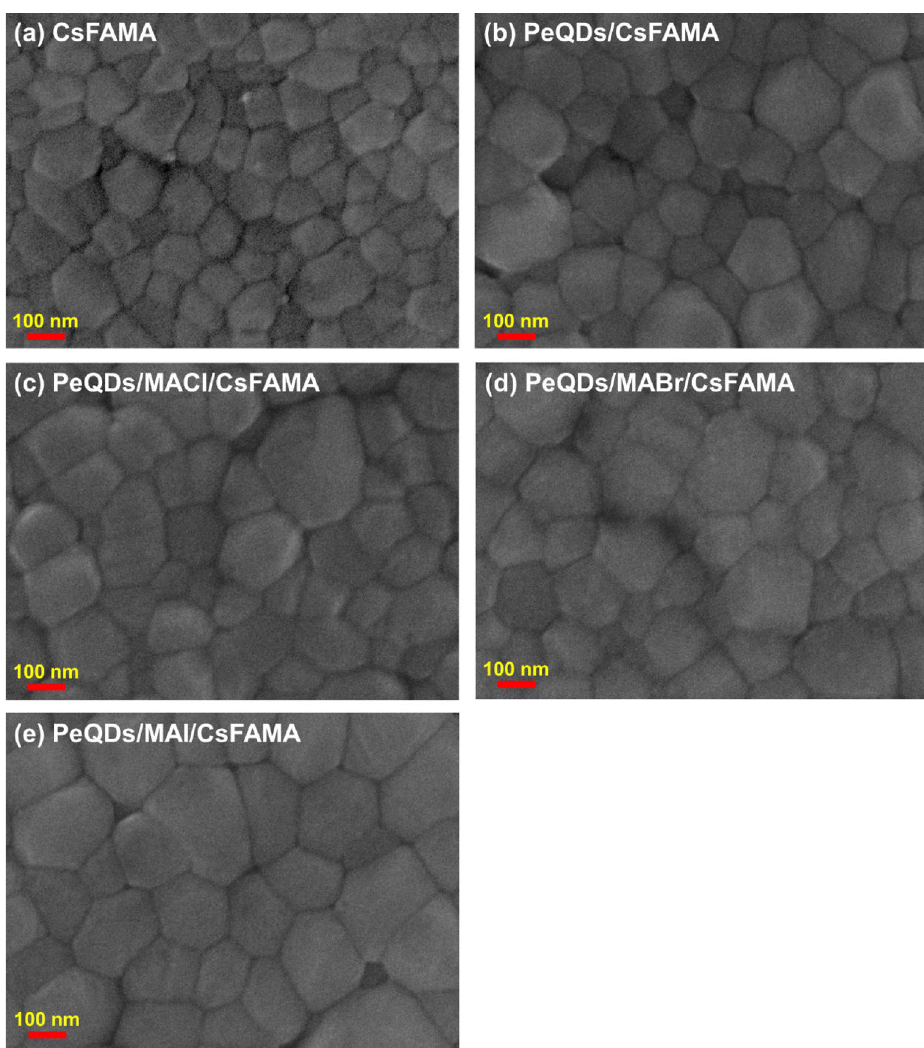
Figure 3. Top view SEM images of the ( a ) CsFAMA, ( b ) PeQDs/CsFAMA, and ( c–e ) PeQDs/MAX (Cl, Br, I)/ CsFAMA films.